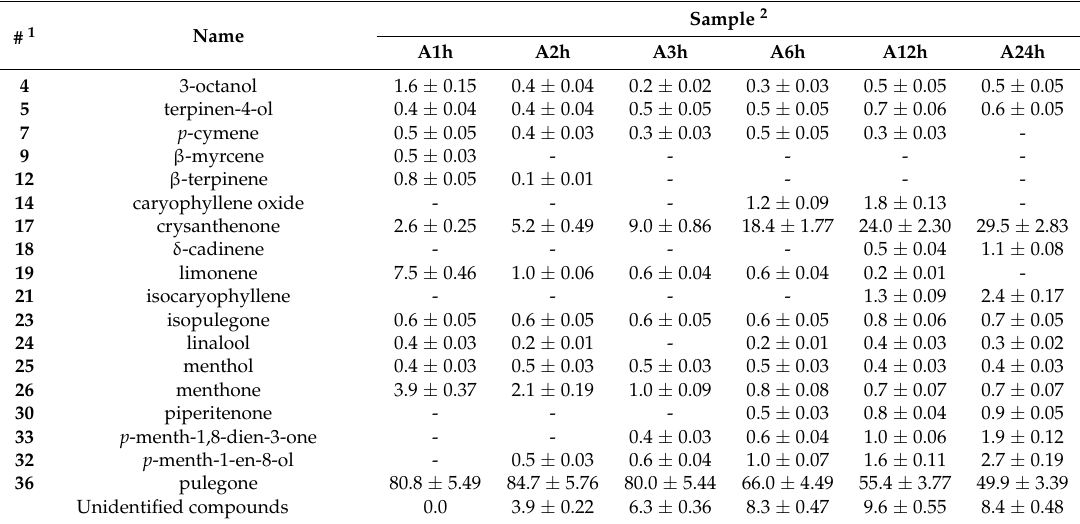
Table 3. Chemical composition (%) of TEOCG extracted in August.